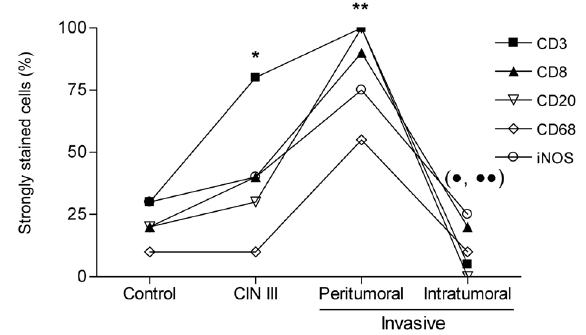
Figure 2 - Distribution of immunohistochemically labeled cells. T lympho- cytes (CD3+ and CD8+), B lymphocytes (CD20+), macrophages (CD68+) and cells that express iNOS from patients in the control group, the CIN III group and the group with invasive carcinomas of the uterine cervix in the peritumoral stroma and the intratumoral microenvironment were detected by immunohistochemistry as described in the “Materials and Methods” section. * P < 0.002, CD3+ compared with control; ** P < 0.01, all markers compared with CIN III (except CD3 and iNOS) and control; · P < 0.005, all markers compared with peritumoral; ·· P < 0.05, CD3+ and CD20+ compared with CIN